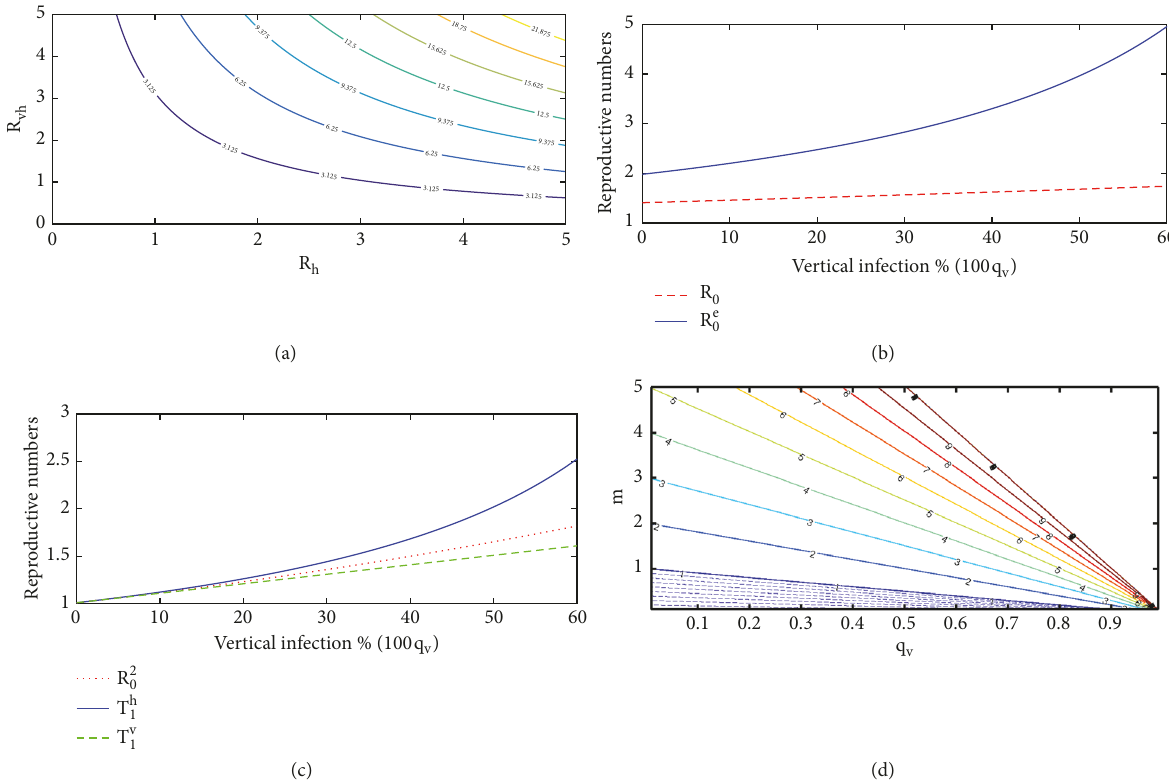
Figure 1: Relationships among epidemicthresholds with respectto verticaltransmission and ratioof mosquitoesto hosts.(a) Therelationship between numberof newinfections in hosts and numberof new infections in vectors.(b) Comparison between basic reproductive numbers 𝑅 0 and 𝑅 𝑒 0 derived from two different methods with respecttovertical infection. (c) Comparison of behavioursamong the completetransmission cycle 𝑅 2 0 and hosttype and vectortypereproductivenumberswith respecttoverticaltransmission efficiencyawayfrom the common epidemic criterion. (d) How the ratio of mosquitoes to hosts 𝑚 and vertical infection 𝑞 V contribute to patterns of 𝑅 𝑒 0 . Dashed lines indicated contours lines for 𝑅 𝑒 0 < 1 while continuous lines are for 𝑅 𝑒 0 ⩾ 1